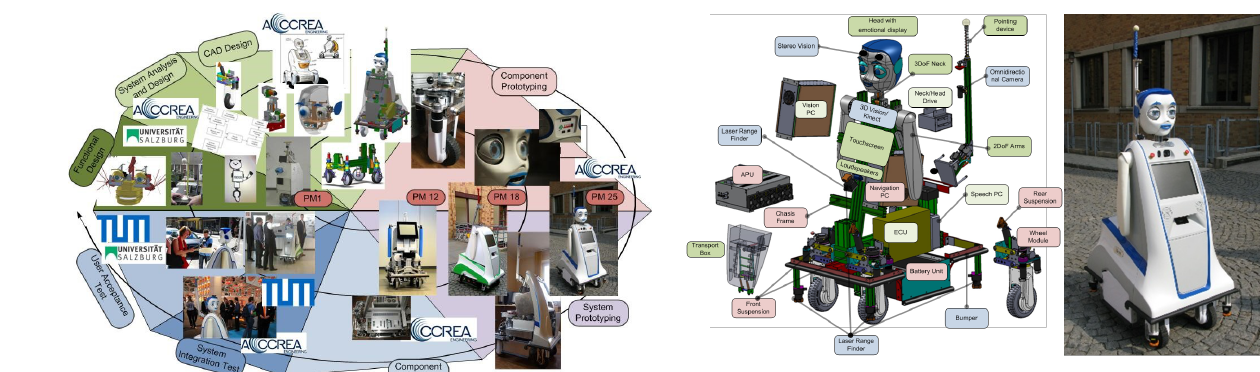
Figure 3: Mechanical construction of IURO and hardware manufac-